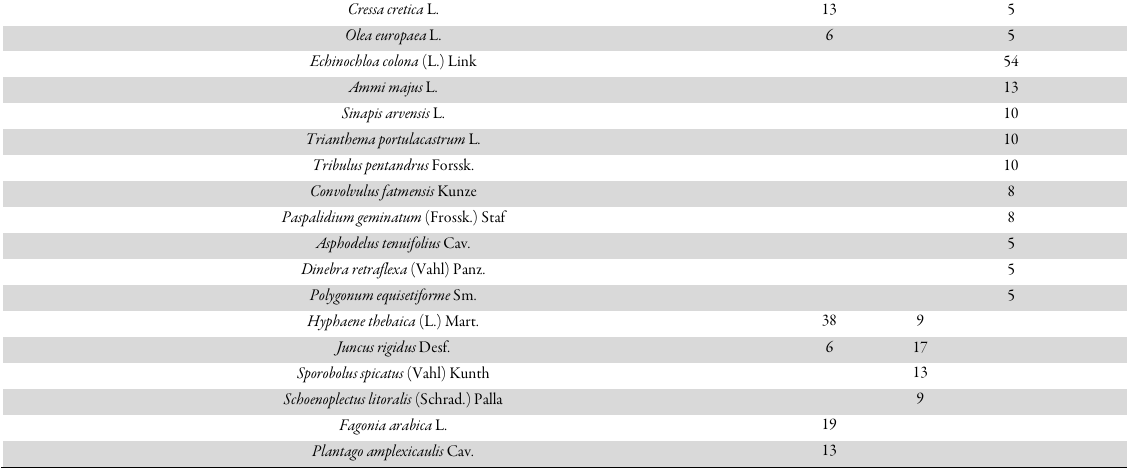
Electrical conductivity (EC) (mS cm -1 )